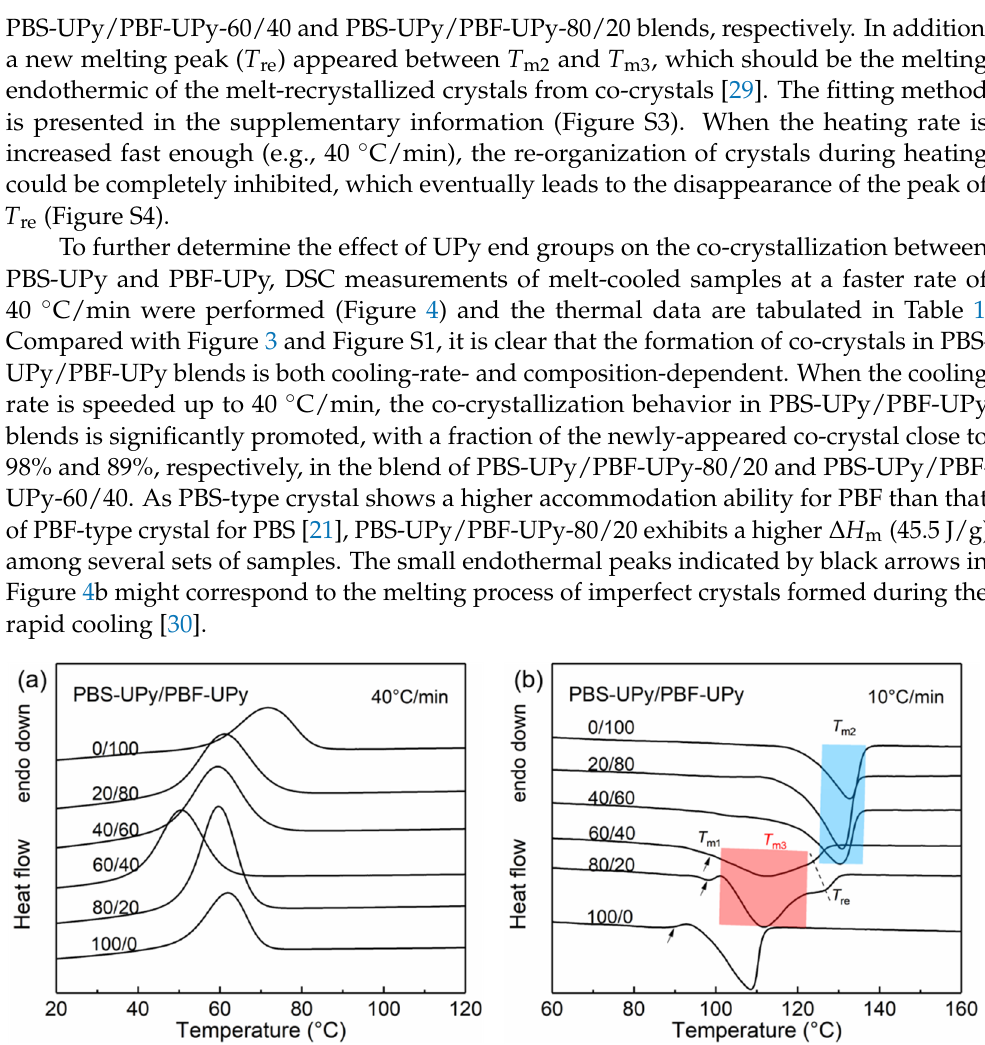
Figure 4. DSC curves of PBS ‐ UPy/PBF ‐ UPy blends during melt ‐ cooling at a rate of 40 °C/min ( a ), and the subsequent heating scans at a rate of 10 °C/min ( b ). Table 1. Thermal data of PBS ‐ UPy/PBF ‐ UPy blends during the heating process at a rate of 10 °C/min after being melt ‐ cooled at a rate of 40 °C/min.